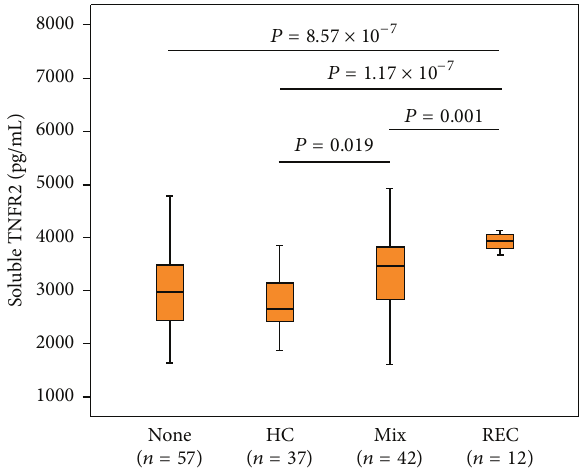
Figure 1: Distributions of serum soluble TNF- 𝛼 (sTNFR2) levels among patients with different iron deposition patterns are